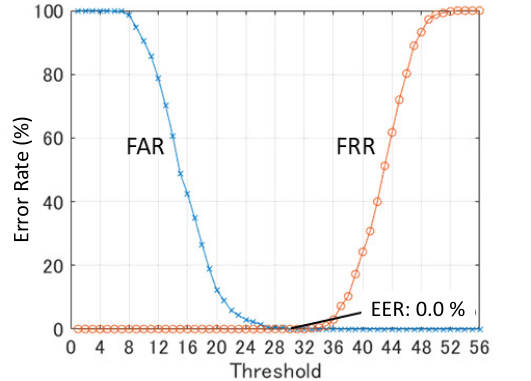
Figure 13. Error rate curves when fusing all